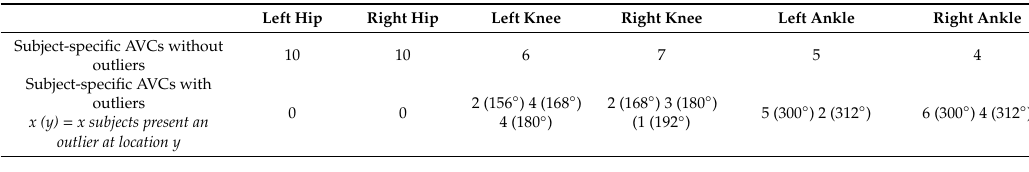
Table 4. Outcome subject-specific B&A analysis.